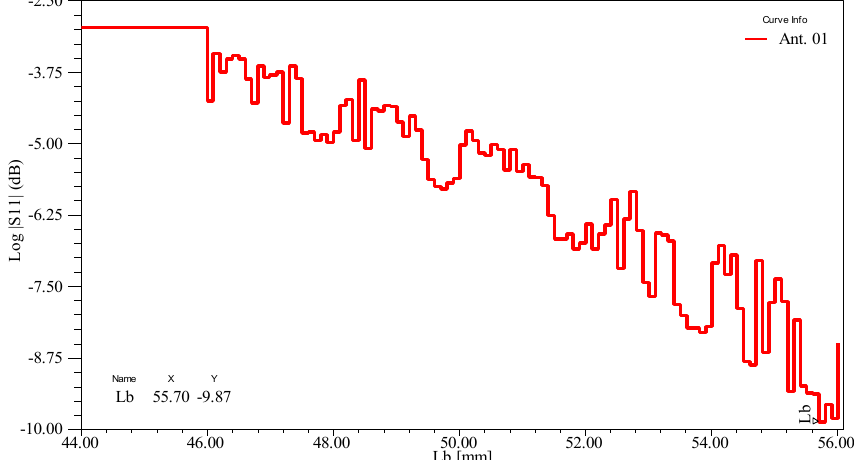
Figure 5. Reflection coefficient of Slot antenna 1 at 2450 MHz versus Lb (mm).